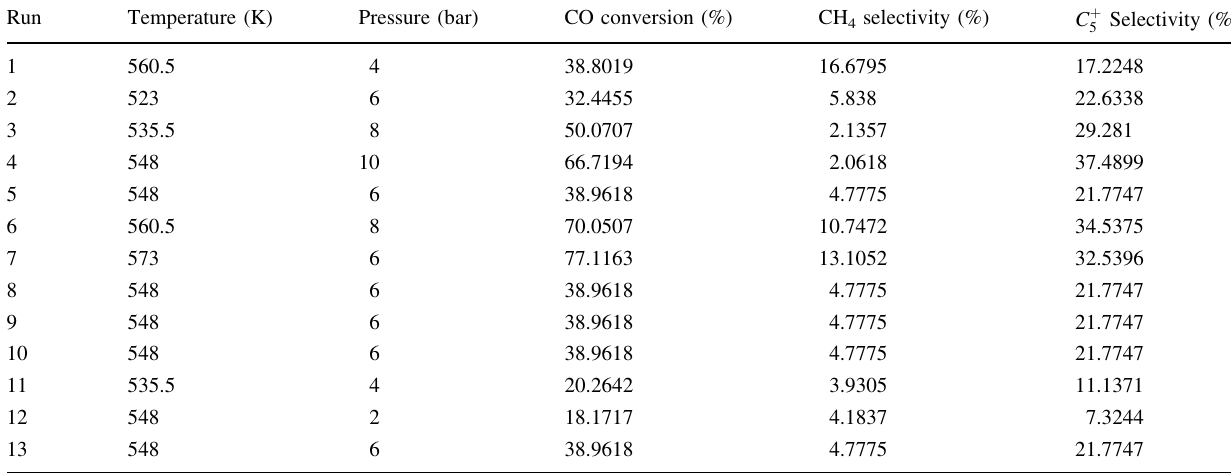
Table 1 DOE points and simulated